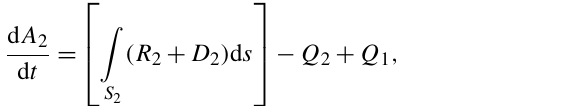
Over a long period, the change in water storage d W (cid:17) (cid:16) d W ≈ 0 , thus d t P − E ≈ R +